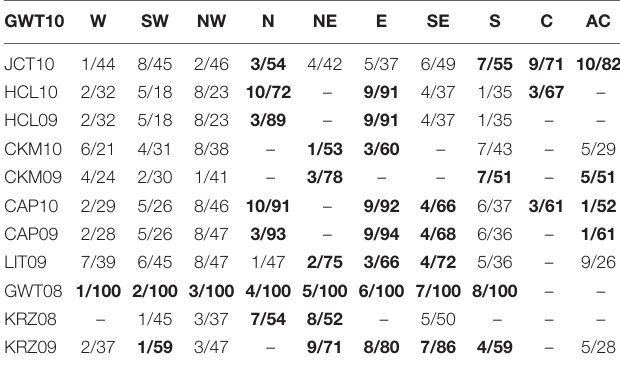
TABLE 2 | Visually similar circulation types and percentage of co-occurrence. First column: names of classifications.